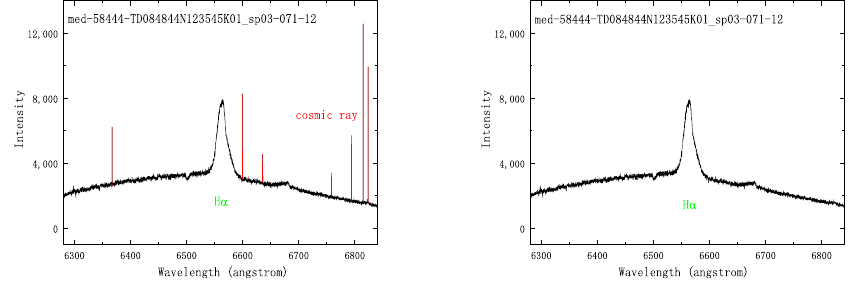
Figure 2. Observed medium-resolution LAMOST spectra with cosmic rays ( left ) and reduction spectra with no cosmic rays ( right ). The red lines are cosmic rays in the observed spectra.